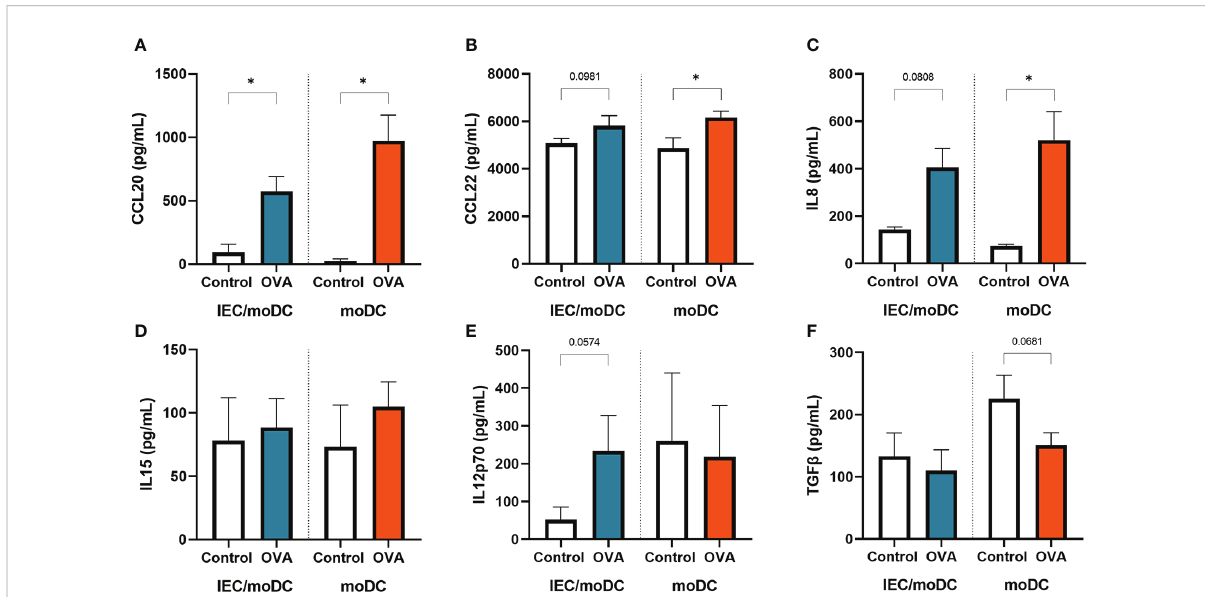
FIGURE 3 After 48h OVA exposure of IEC-moDC or moDC alone, secretion of (A) CCL20, (B) CCL22, (C) IL8, (D) IL15, (E) IL12p70, and (F) TGF b was determined in the basolateral compartment. Data is analyzed by paired t-test, n=3, mean ± SEM (*